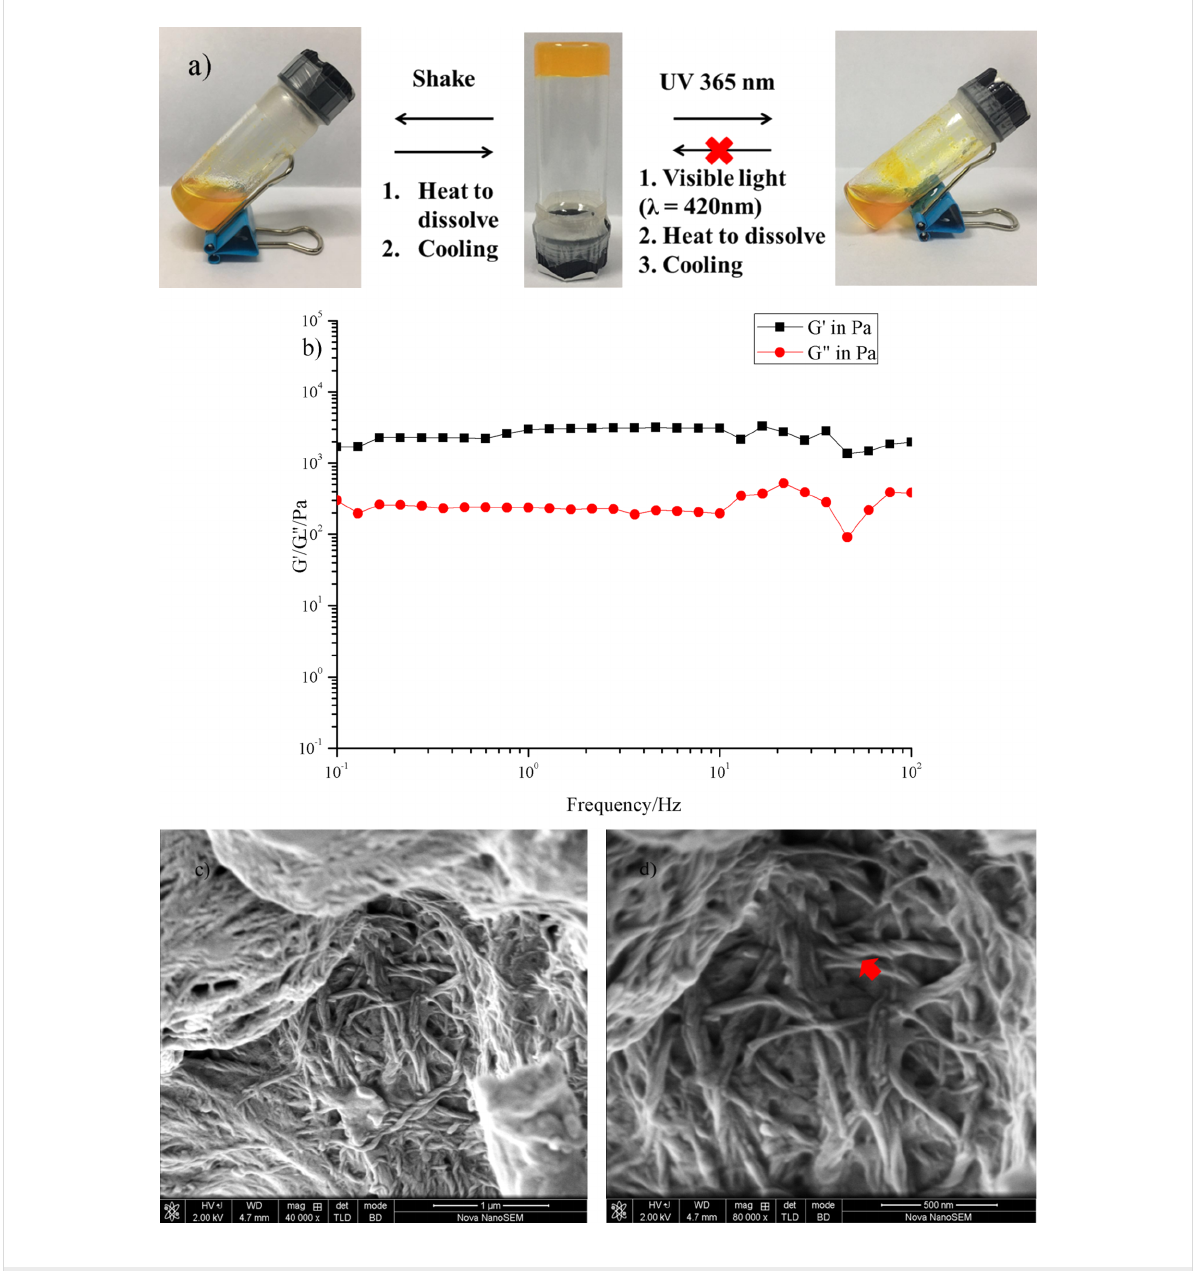
Figure 5: a) The gel-to-sol transformation of the samples via different routes. b) Dynamic frequency sweep of the gel fabricated in benzene. (c,d) FESEM images of compound 3 xerogels.